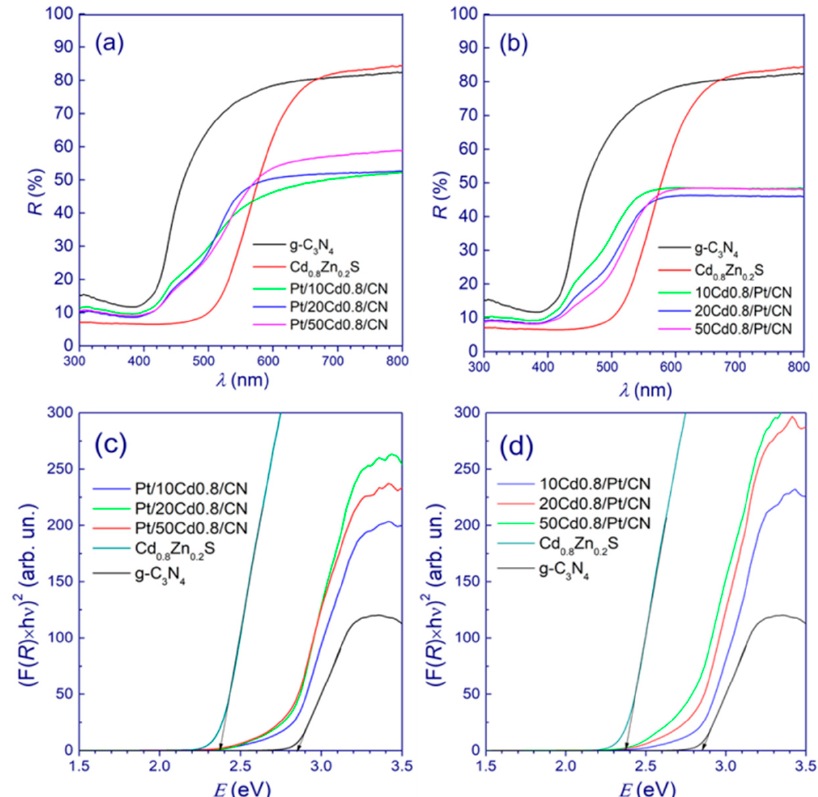
Figure 2. Diffuse reflectance spectra ( a , b ) and Tauc plot ( c , d ) for the samples Cd 0.8 Zn 0.2 S, g-C 3 N 4 , Pt/Cd0.8/CN (Scheme 1) ( a , c ), and Cd0.8/Pt/CN (Scheme2) ( b , d ).